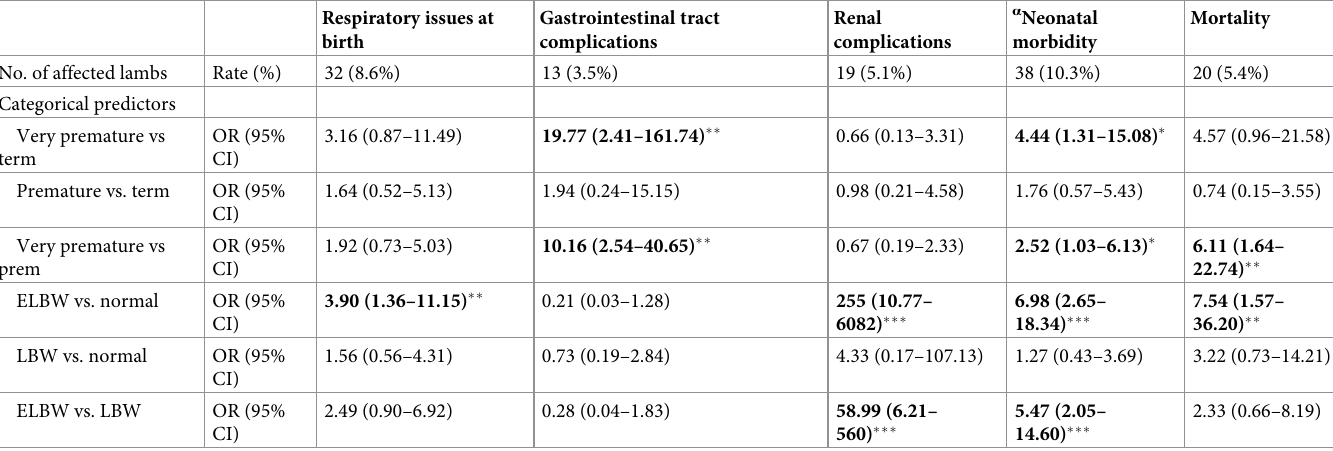
Table 6. Risk of respiratory issues at birth, neonatal morbidity or mortality in relation to delivery and birthweight